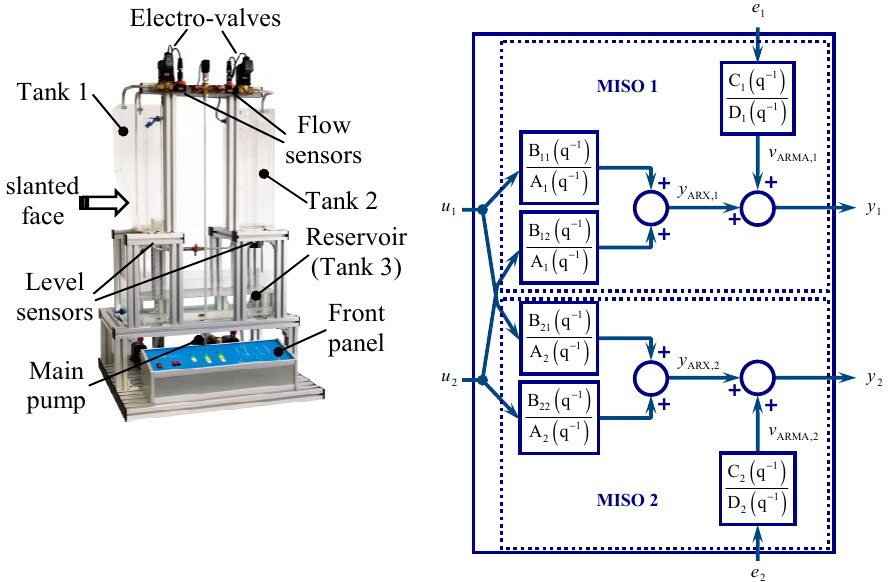
Figure5. PhotoofASTANK2installation( left )andtheschemeofassociatedmultivariableautoregressive Figure 5. Photo of ASTANK2 installation ( left ) and the scheme of associated multivariable identification model ( right autoregressive identification model ( right ).